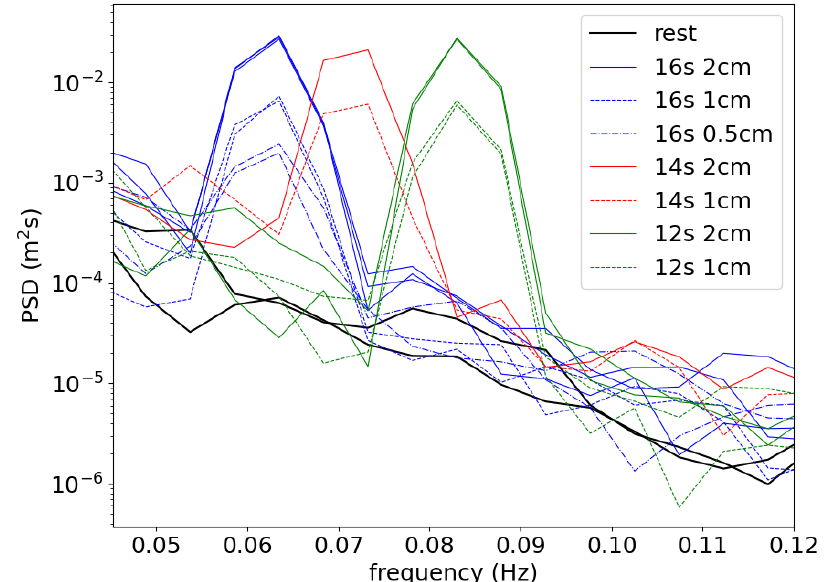
Figure 5. Spectra obtained when testing the instrument v2021 in the laboratory. The signal-to-noise ratio is superior or equal to 50 for all test cases, except the “extreme” test case with displacements of amplitude 0.5 cm and period 16 s, where the signal-to-noise ratio is around 10. The noise threshold obtained when the instrument is at rest is actually slightly better than what was obtained with the instrument v2018 (compare the present plot with Figure 3 of Rabault et al. [51], curves “IMU 1” and “IMU